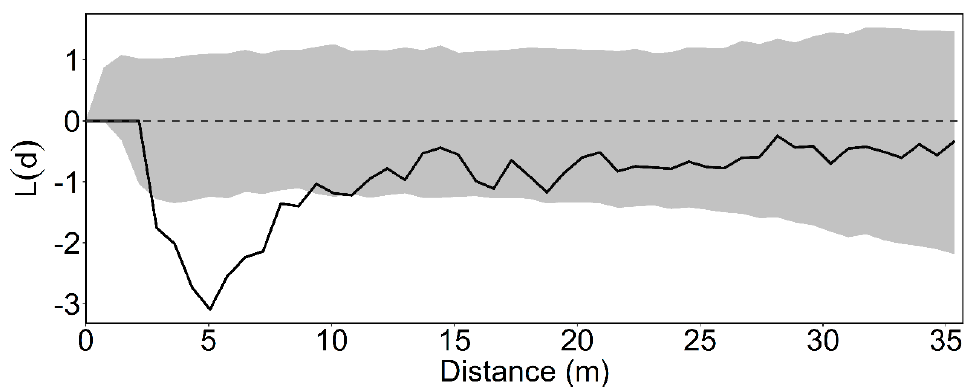
Figure 2. Variance-block length graph for the four-term local quadrat variance (4TLQV) and the nine- quantile bounds, suggesting a random distribution of adult trees farther than 9 m. term local quadrat variance (9TLQV) for saplings (stems with height ≥ 1.30 m and dbh < 10 cm).